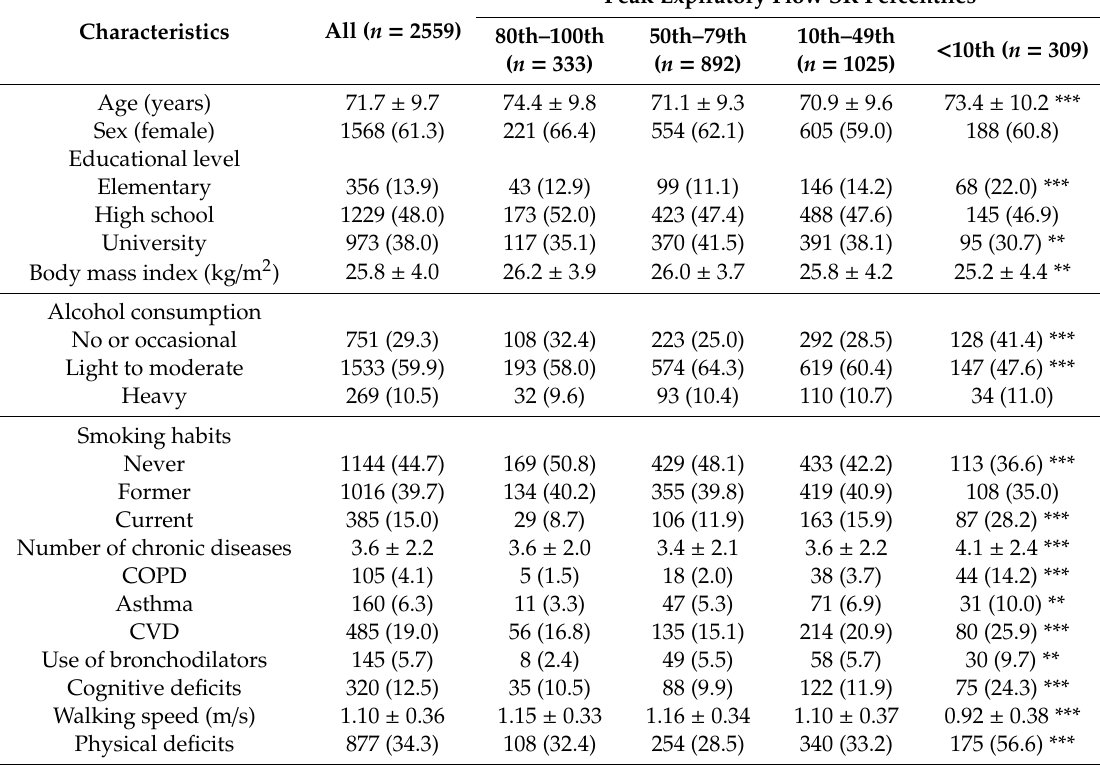
Table 1. Overall participant baseline characteristics and by peak expiratory flow (PEF) standardized residual percentiles.